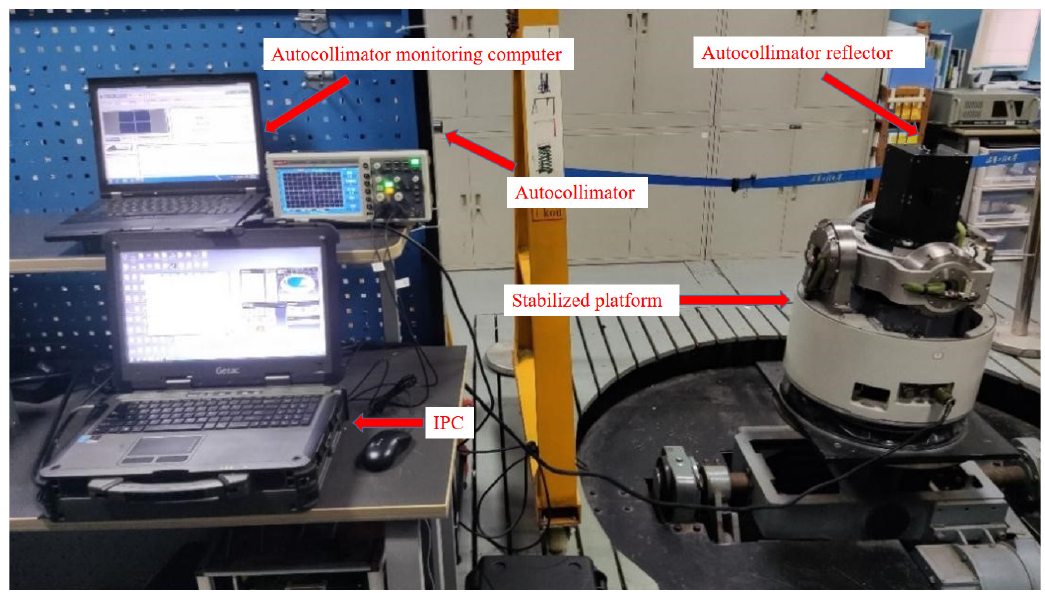
Figure 11. The experimental environment of the platform laboratory.